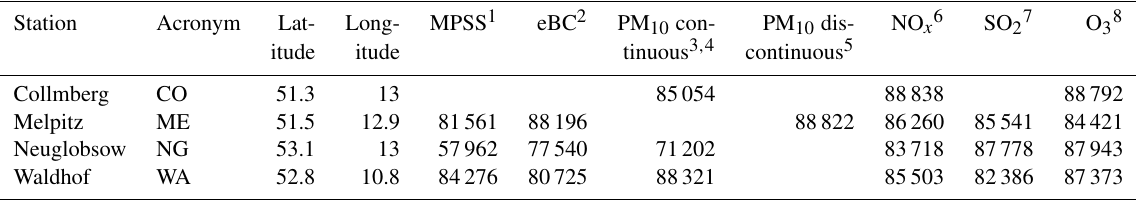
Table 1. Characteristics of the four stations in the present study; see the text for instrumental details. The number of validated data hours is given for each